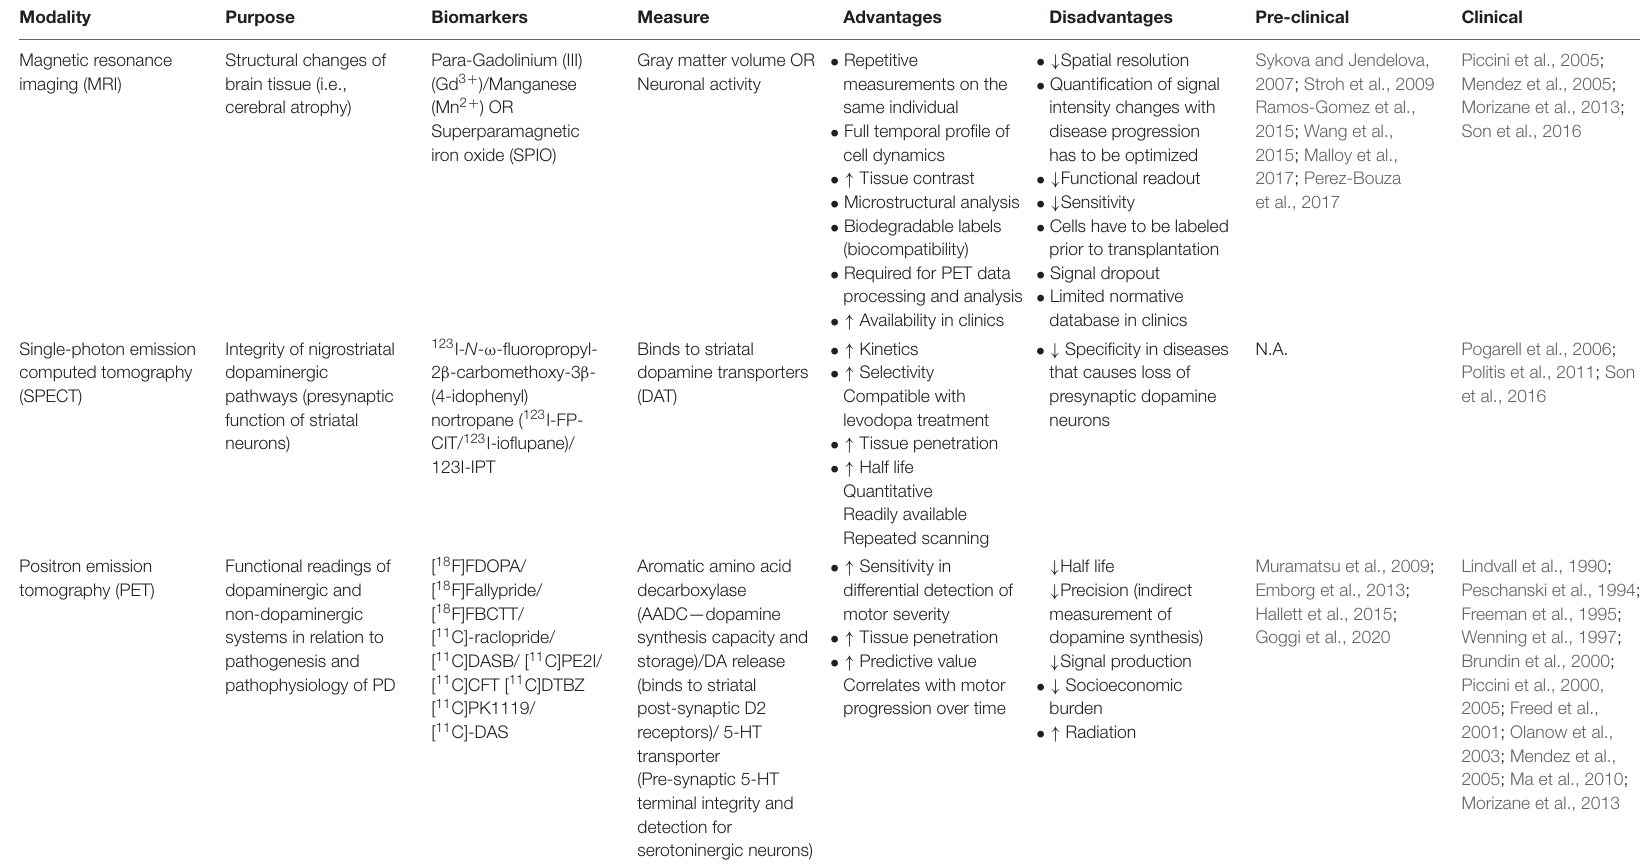
TABLE 2 | Imaging modalities used in cell transplantation for